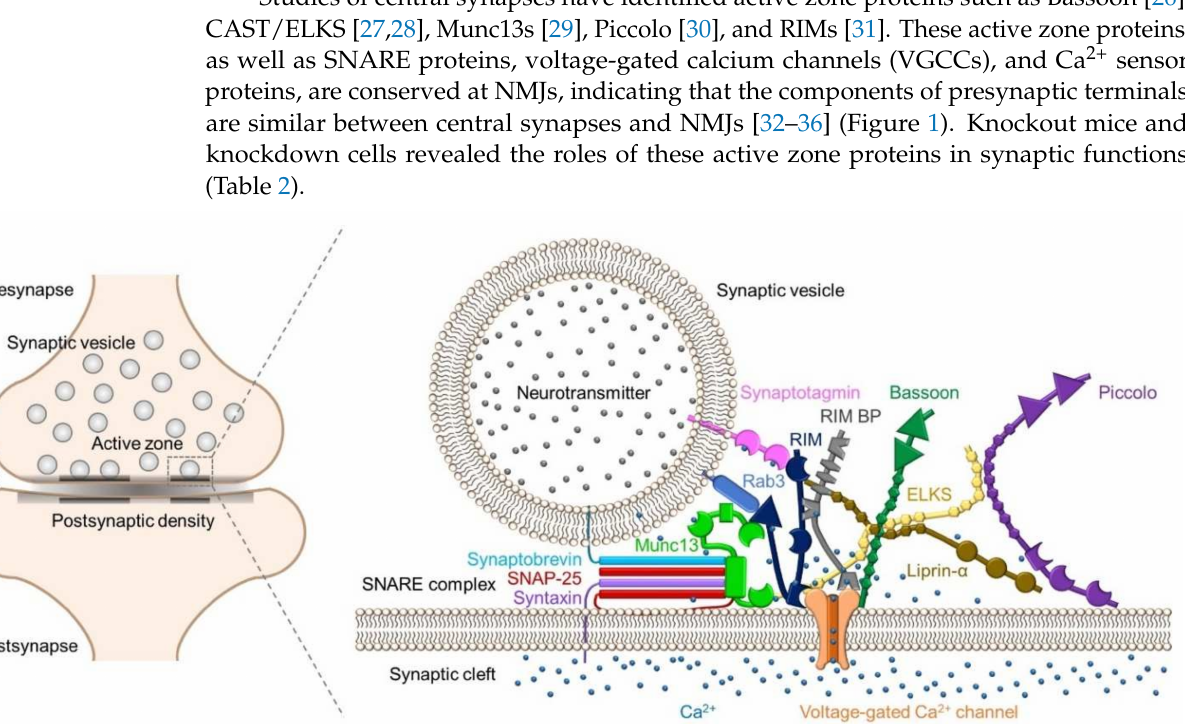
Figure 1. Schematic representation of the presynaptic protein complex containing SNARE proteins, active zone proteins, synaptic vesicle proteins, and voltage-gated calcium channels in an active